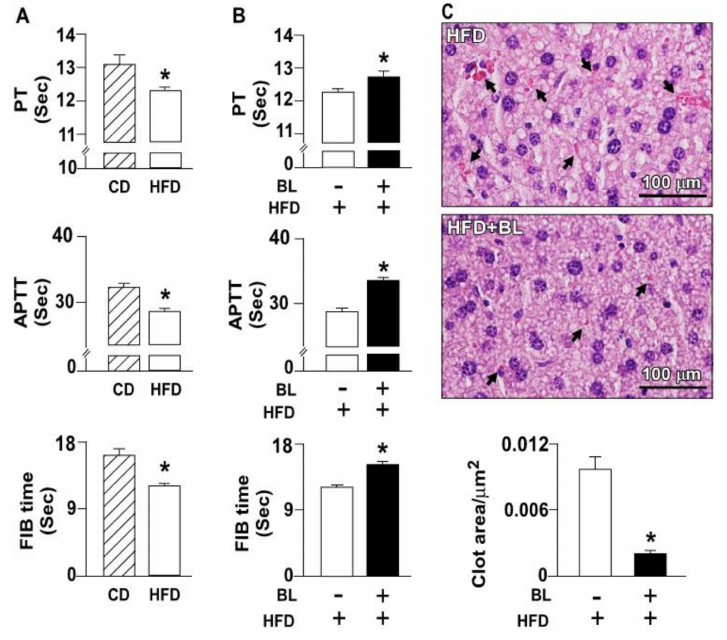
Figure 1. Bromelain (BL) alleviates high-fed diet (HFD)-induced deregulation of blood coagulation and decreases thrombus formation in the liver. ( A ) Prothrombin time (PT), activated partial throm- boplastin time (APTT), and fibrinogen (FIB) time in chow diet (CD)- and HFD-fed mice. ( B ) PT, APTT, and FIB time in HFD-fed mice with or without BL administration. ( C ) Histological images of hematoxylin and eosin Y-stained liver samples and the quantification of clot area. Clots are indi- cated by arrows. Scale bar represents 100 µ m. Data represent the mean ± standard error of mean (SEM) from 10 mice. * p < 0.05 vs. CD group or HFD alone group. Abbreviations: APTT, activated partial thromboplastin time; BL, bromelain; CD, chow diet; FIB, fibrinogen; HFD, high-fed diet; PT, prothrombin